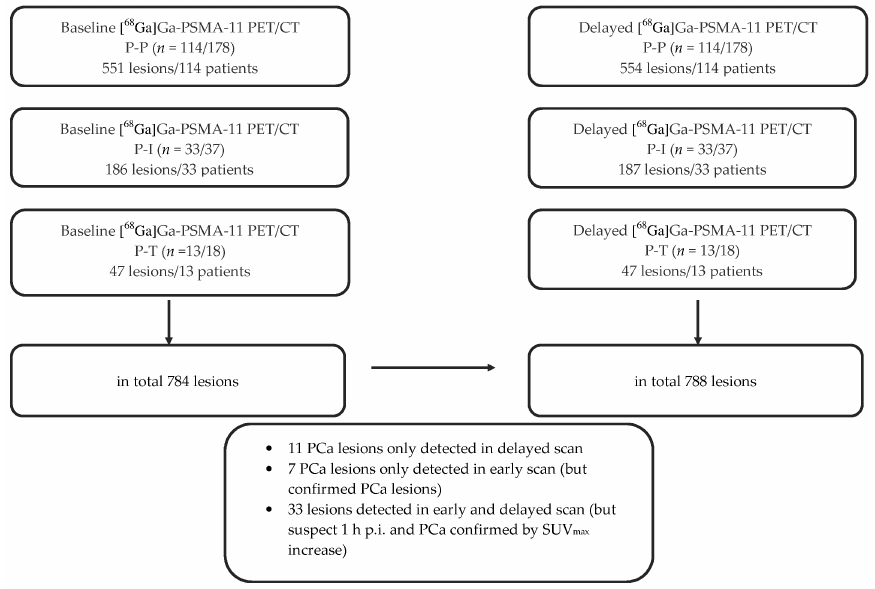
Figure 1. Flow chart showing baseline and delayed [ 68 Ga]Ga-PSMA-11 PET / CT results regarding LPR in patients.